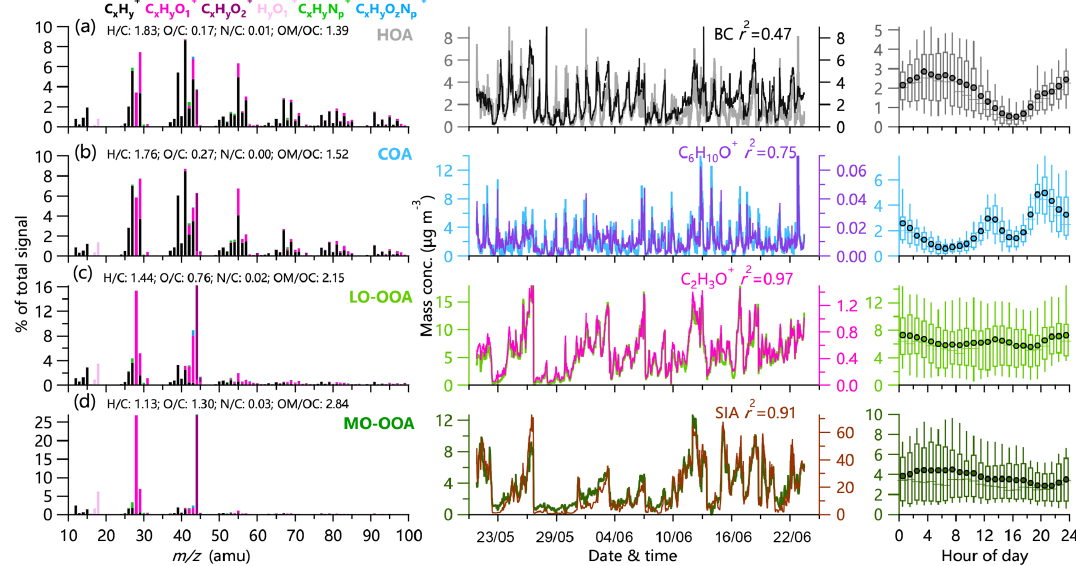
Figure 1. High-resolution mass spectra (left panels), time series (middle panels), and diurnal patterns (right panels) of four OA factors in summer 2018: (a) HOA, (b) COA, (c) LO-OOA, and (d) MO-OOA. Also shown in the middle panels are the time series of other tracers, including BC, C 6 H 10 O + , C 2 H 3 O + , and